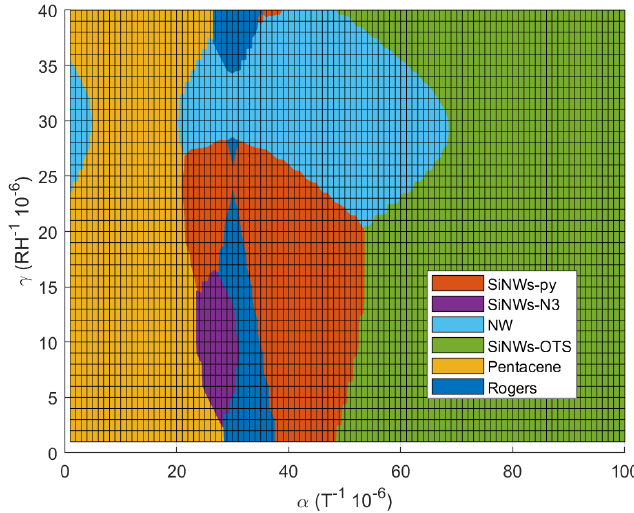
Figure 13. Likelihood representation of the 6